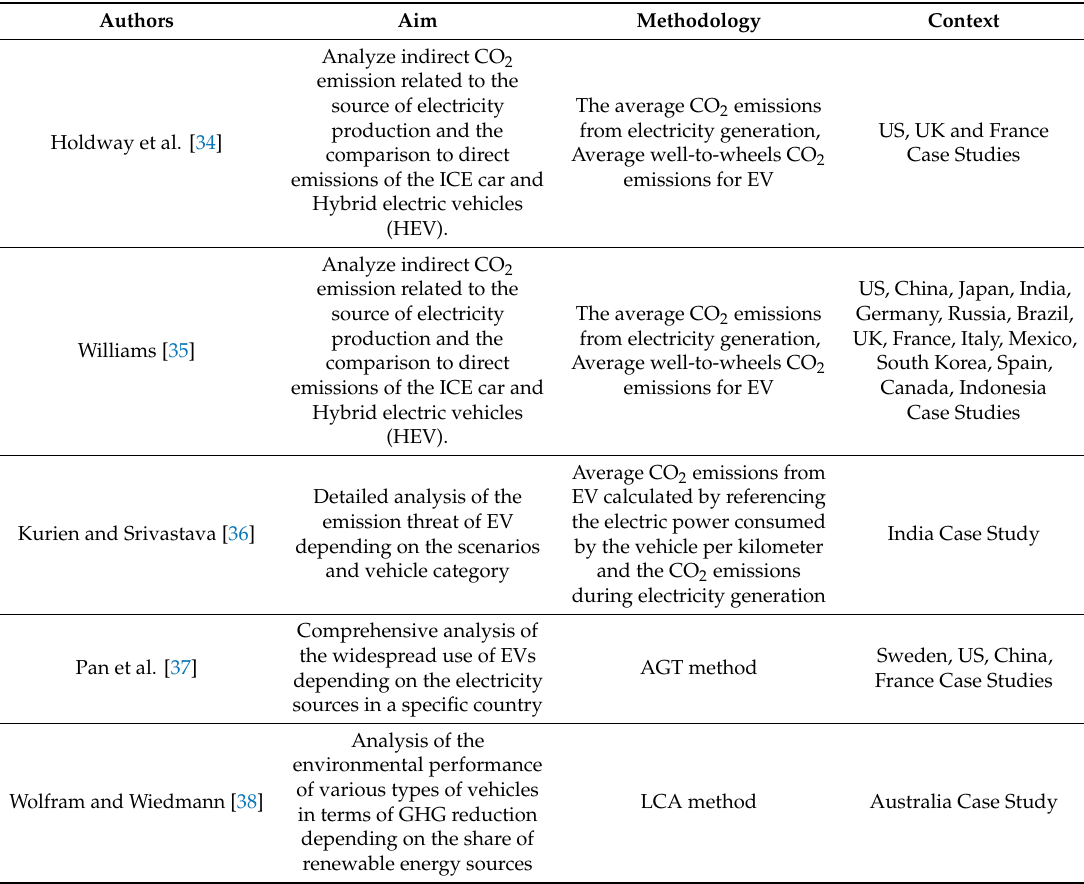
Table 1. Main case studies in the